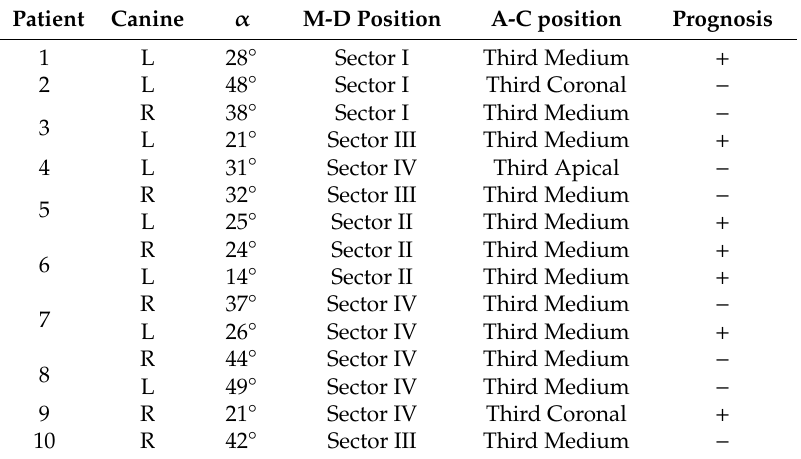
Table 1. Evaluation of the impacted canines by the OPT ( α : angle between the major axis of the canine and the perpendicular to the occlusal plane, M-D position: mesio-distal position of the canine’s crown, A-C position: apical-coronal position of the canine’s crown, Prognosis: positive or negative prognosis of the canine).